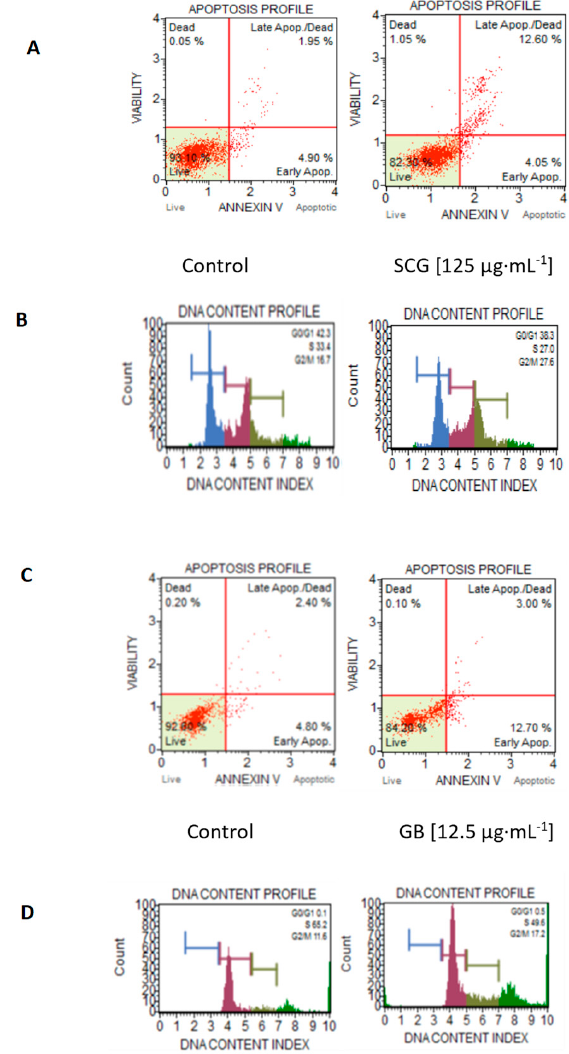
Figure 3. Effect of ethanolic coffee extracts on apoptosis and cell ‐ arrest cycle in C33A and A549 cells. ( A ) Representative result of Annexin V assay to detect apoptosis, by the addition of 125 μ g ∙ mL − 1 of the SCG ethanolic extract, compared with control. ( B ) An example of the analysis of cell ‐ cycle phases by flow cytometry; with the addition of 125 μ g ∙ mL − 1 , the SCG ethanolic extract caused cell ‐ cycle arrest. Different concentrations of ethanolic and aqueous extracts from GB and SCG were evaluated in A549 cells. ( C ) Representative result of Annexin V assay to detect apoptosis, with induction of apoptosis by the addition of 12.5 μ g ∙ mL − 1 of the GB ethanolic extract compared with control. ( D ) An example of the analysis of cell ‐ cycle phases by flow cytometry, with the addition of 12.5 μ g ∙ mL − 1 of the ethanolic extract.